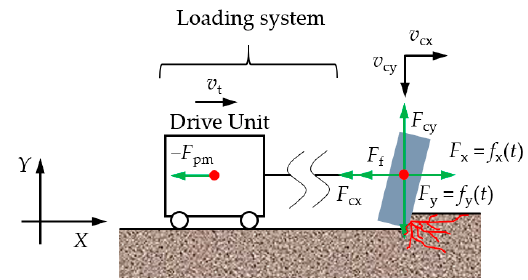
Figure 12. Schematic of the load state of the PDC cu tt er under vertical and horizontal impact load- ing.